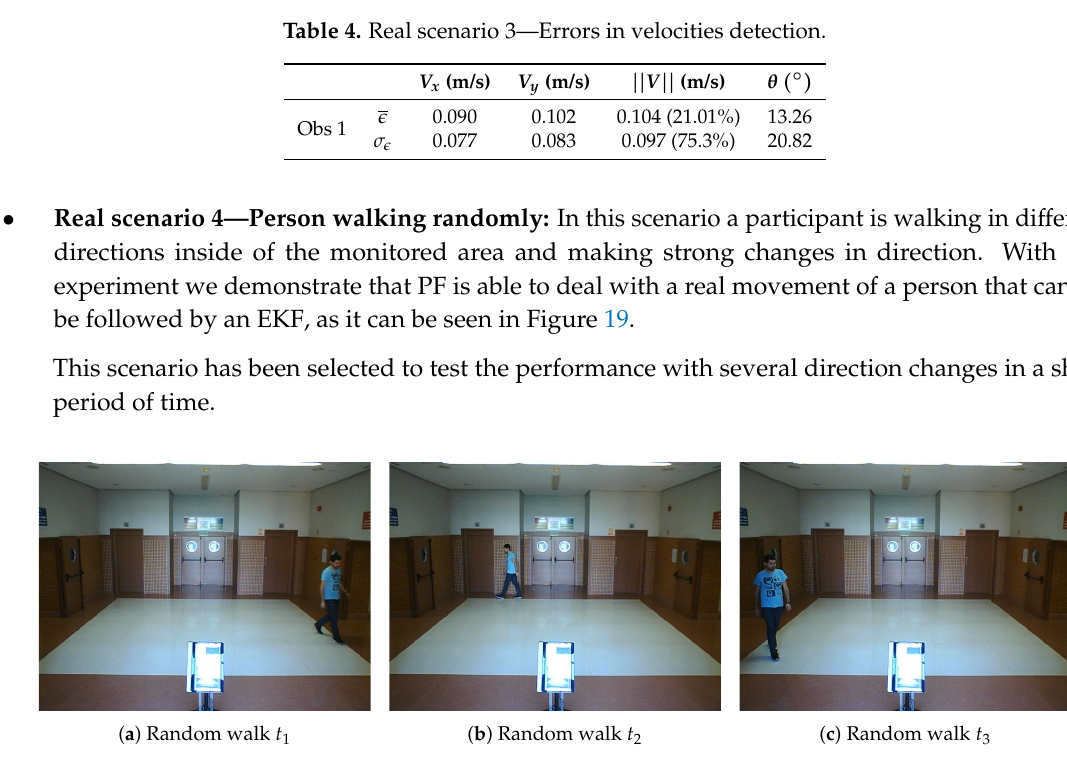
Figure 19. Real scenario 4—Images sequence.